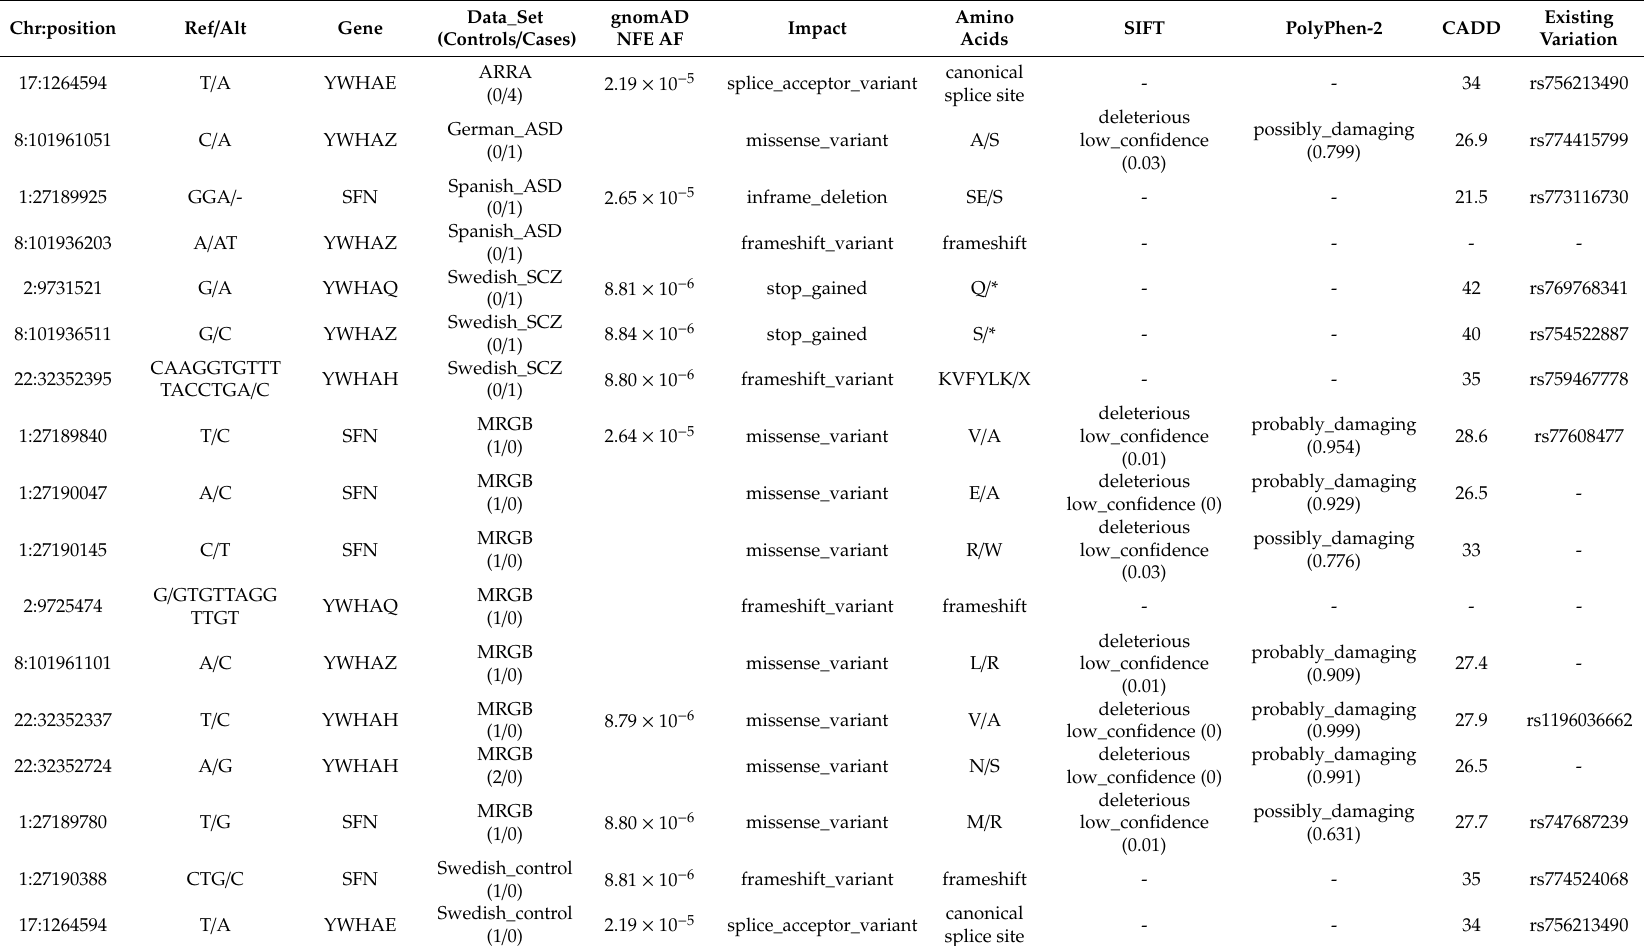
Table 2. List of ultra-rare variants (URVs) across the 14-3-3 gene family found in large public